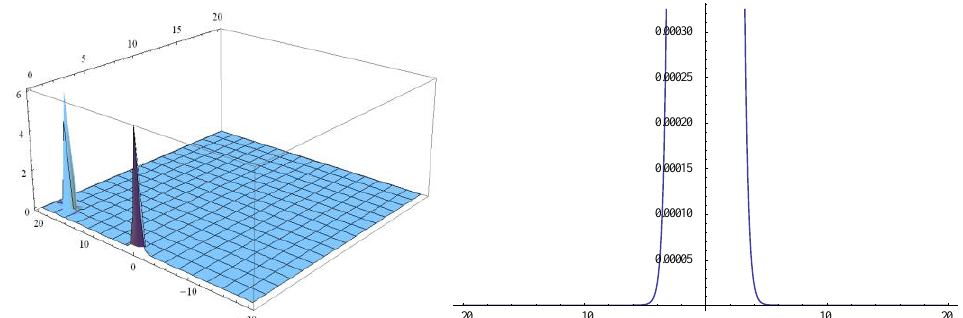
Figure 1. The periodic soliton solution (30) of Equation (1) and its projection at 𝑡 = 0 when 𝐴 = 3, 𝐶 = 4,𝐵 = 1.